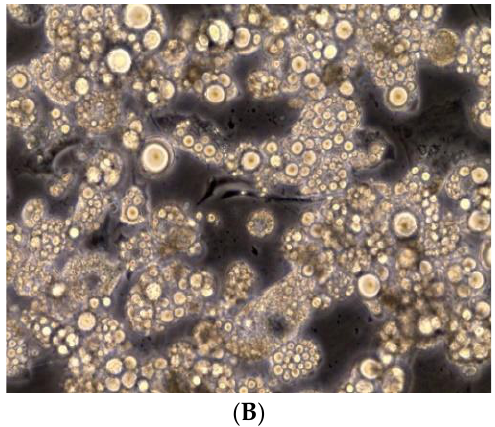
Table 2. Gene-specific oligonucleotide primers of inflammatory cytokines for RT-qPCR. Gene